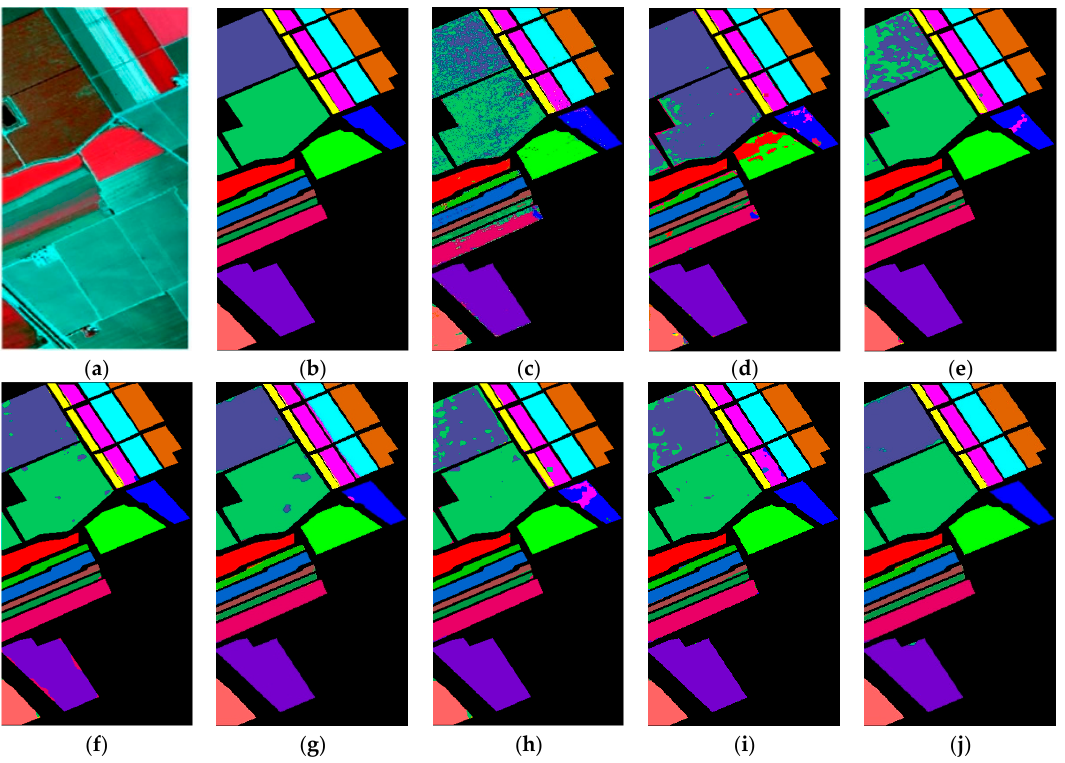
Figure 8. The classification map of Salinas. ( a ) False ‐ color image; ( b ) ground truth; ( c ) SVM; ( d )